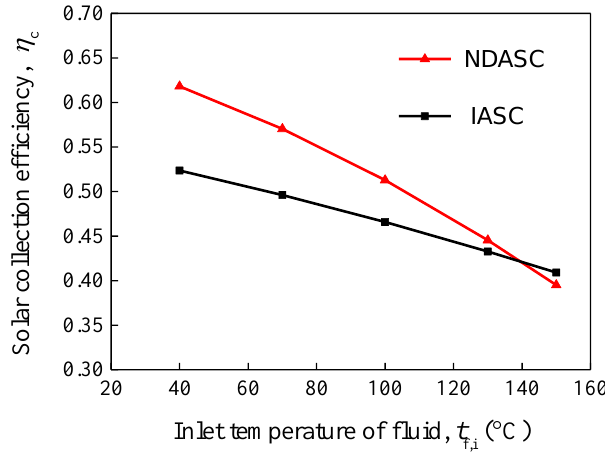
Figure 9. Variations of solar collection efficiencies with t f,i for both the NDASC and the